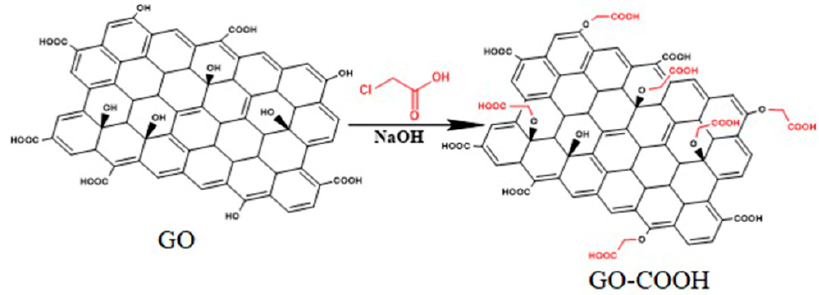
Figure 1. Synthesis of carboxylated graphene oxide .